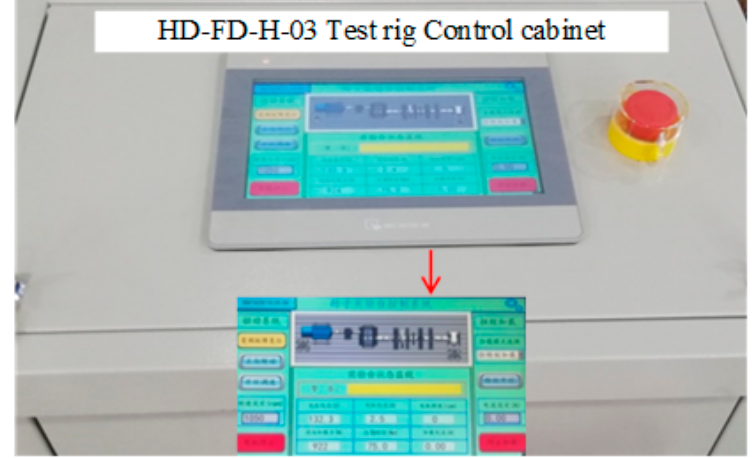
Figure 2. Control cabinet.